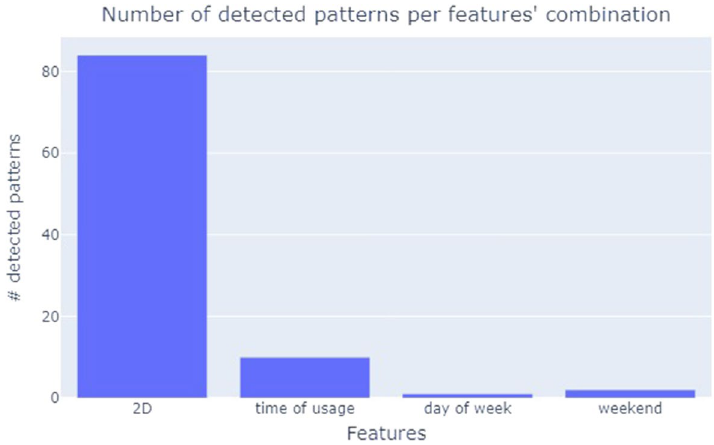
Fig. 5 Number of clusters found with different combinations of